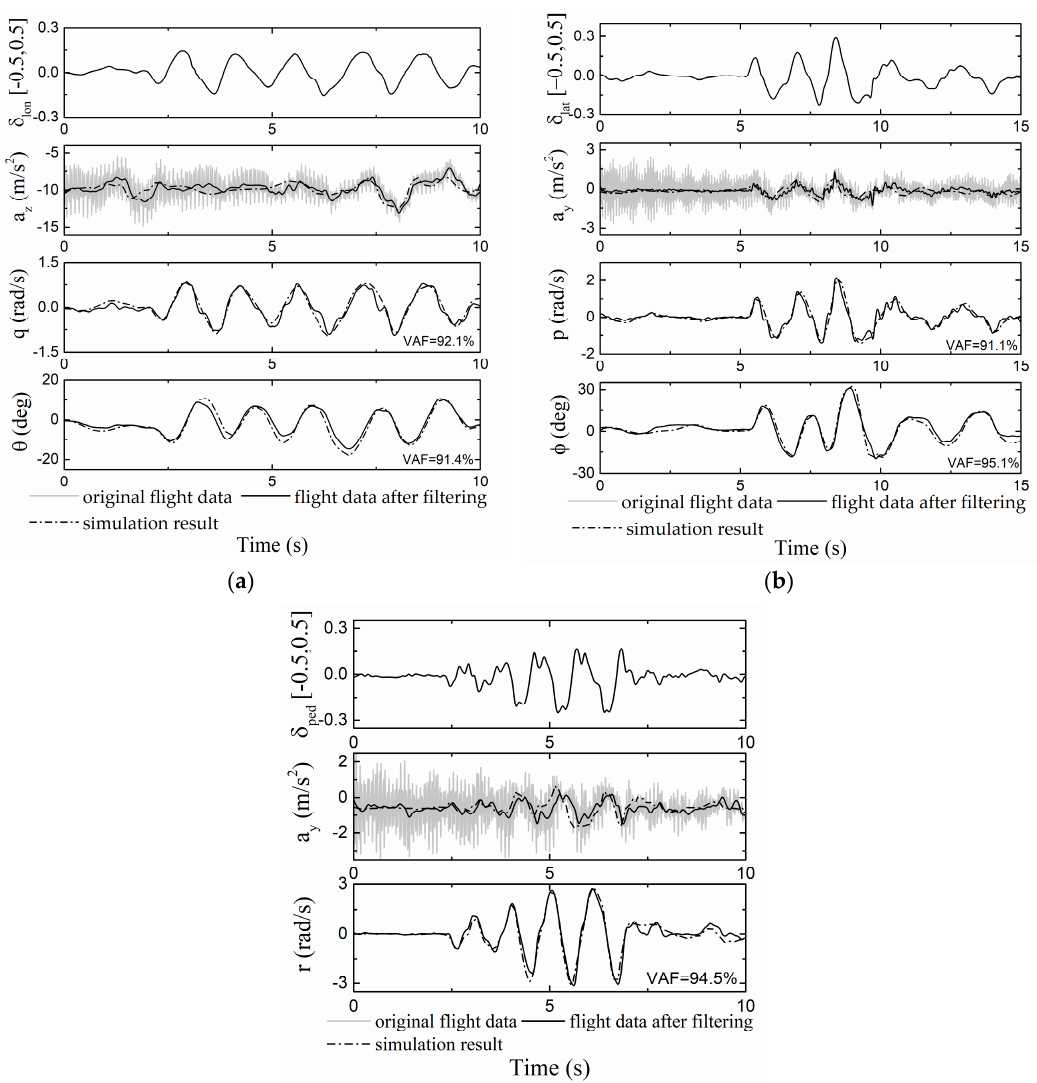
Figure 9. Time domain validation in hover under Configuration D. ( a ) Longitudinal direction; ( b ) Lateral direction; ( c ) Yaw direction.